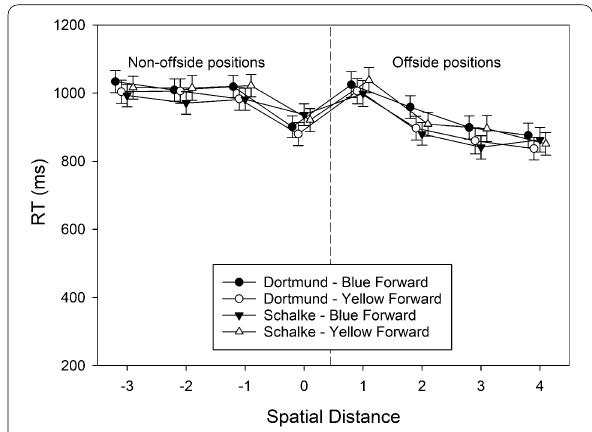
Fig. 10 The RTs of correct offside judgments observed in Experiment 4, plotted as a function of spatial distance (between forward and defender), participants’ team preference (Dortmund vs. Schalke), and shirt colour of the attacking team (blue vs. yellow). Error bars represent standard errors between